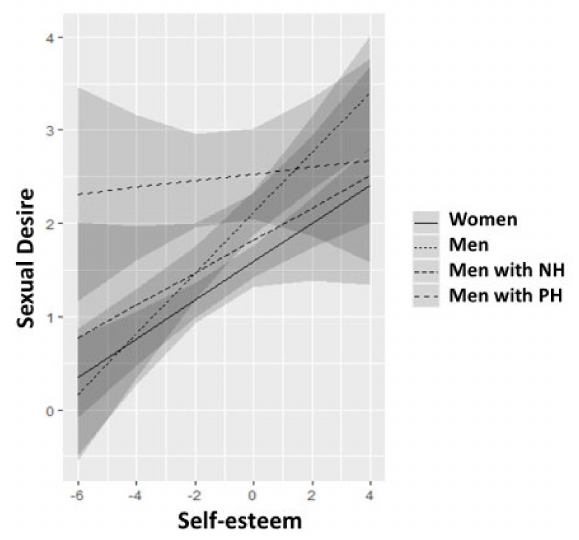
Figure 3. The effect of self-esteem on sexual desire for women, men, men with NH, and men with PH. Only for men with PH self-esteem and sexual desire were not contemporaneously related. For men with NH the association was not significant though the effect was similar to that of women and men from the general population convenience sample. Shaded areas represent 95% confidence intervals.